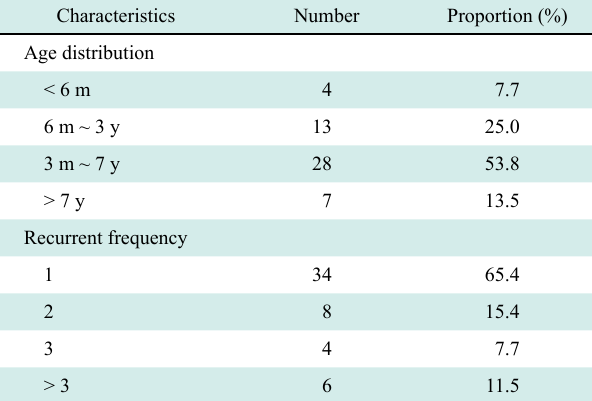
Table 1 Features of 52 recurrent intussusceptions secondary to PLPs Characteristics Number Proportion